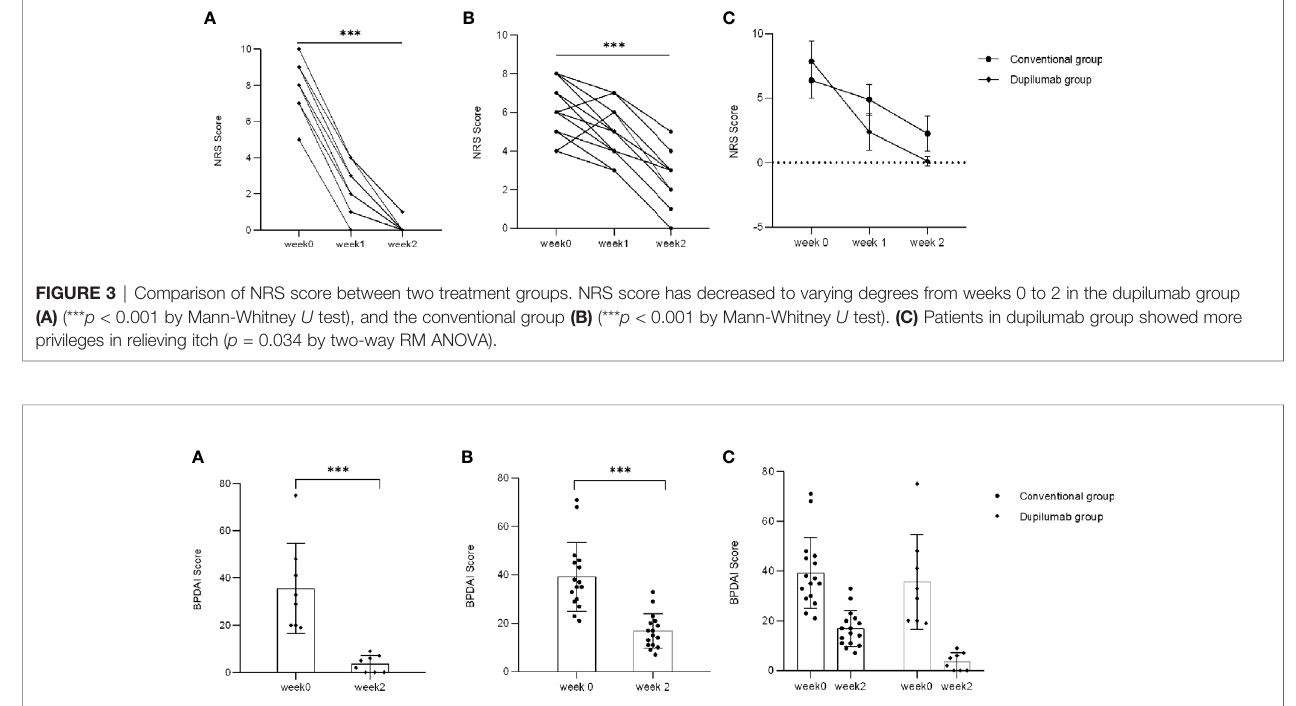
(skin: erosions/blisters) score used in severity determination. The median BPDAI activity score in patients in the dupilumab group was 34.25 (range: 19 – 75) at week 0 and 3.7 (range: 0 – 9) at week